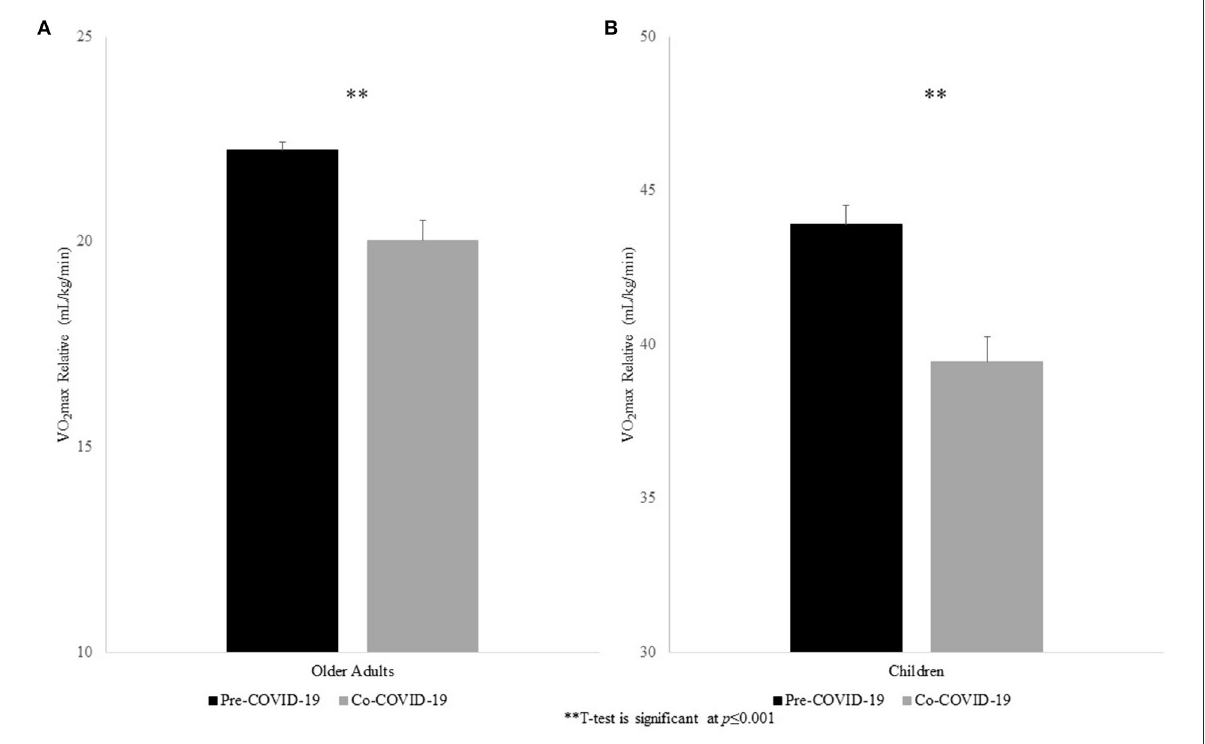
FIGURE1 Relative VO 2 max (Means ± Standard Error) for Pre- and Co-COVID for older adults (A) and children (B)